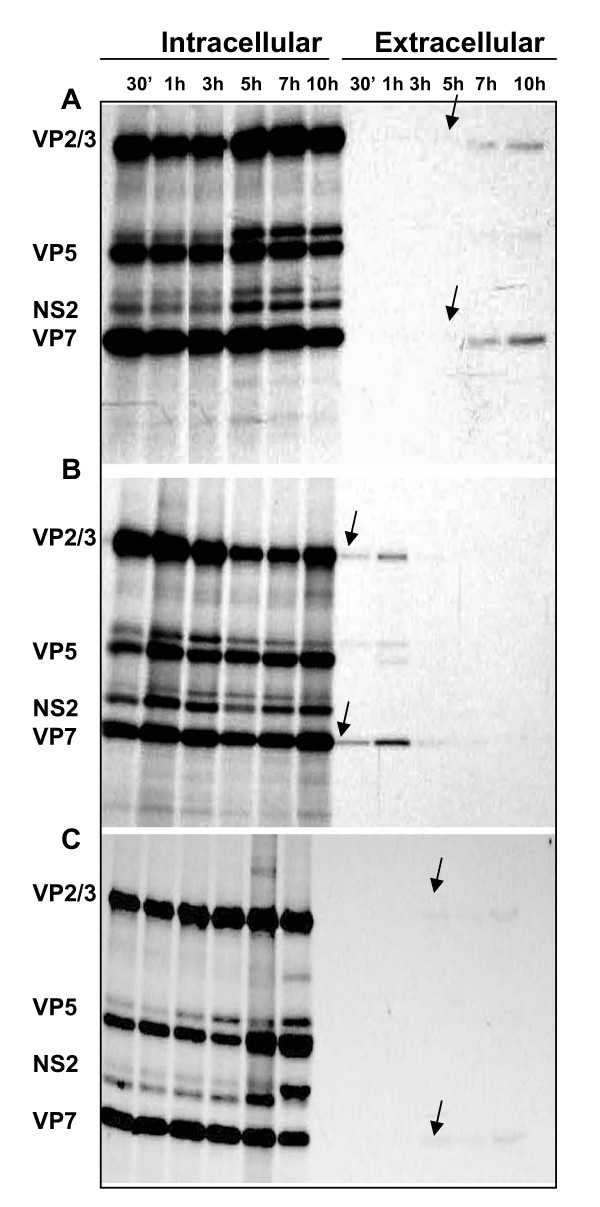
Immunoprecipitation of the BTV proteins in NS2 cell lines. Immunoprecipitation of BTV-10 proteins in NS2 cell lines; WT-NS2 (A), ΔNS2-1 (B) and ΔNS2-2 (C) were infected with BTV-10 and the lysates were precipitated by a polyclonal BTV antisera. The names of the fractions and post chase times are indicated at the top of the panel. Note the early virus release in ΔNS2-1 cells in compared to that of the other two cell lines as indicated by arrows.